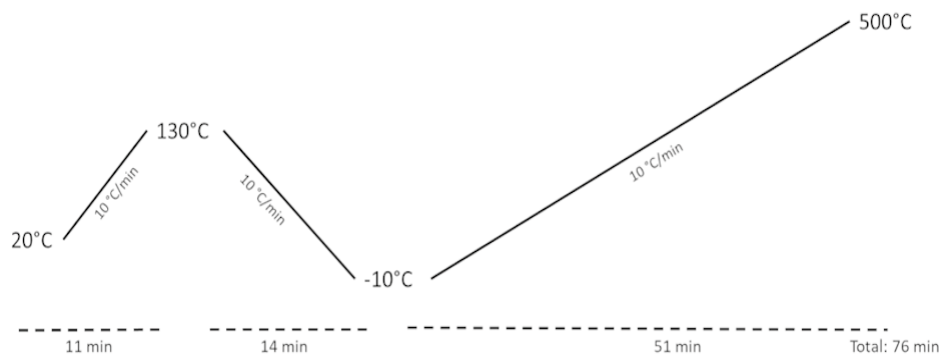
Figure 1. DSC temperature programme.